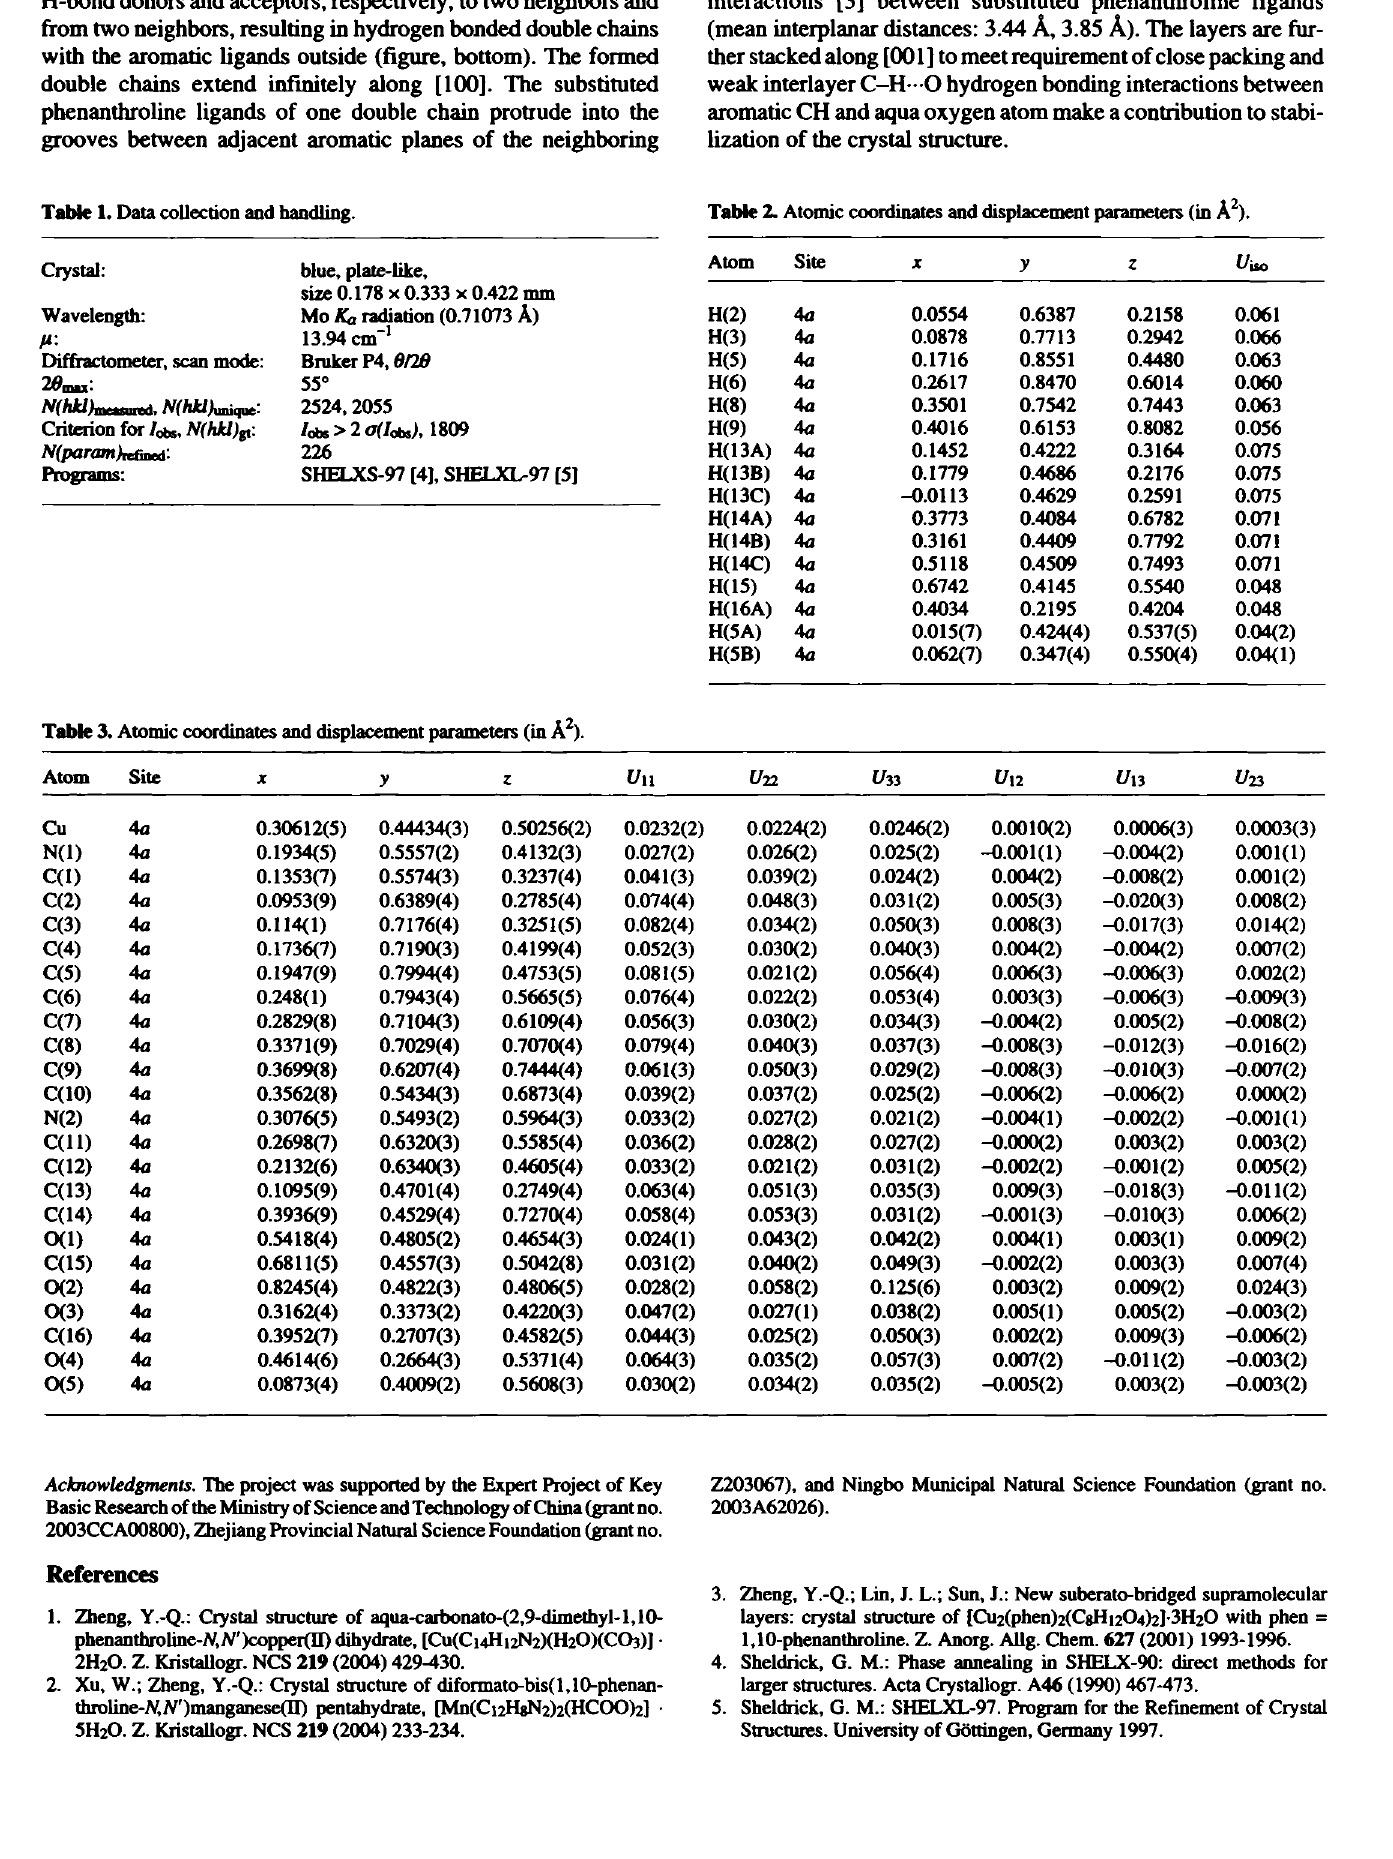
Table 1. Data collection and handling. Table 2. Atomic coordinates and displacement parameters (in A 2 ).